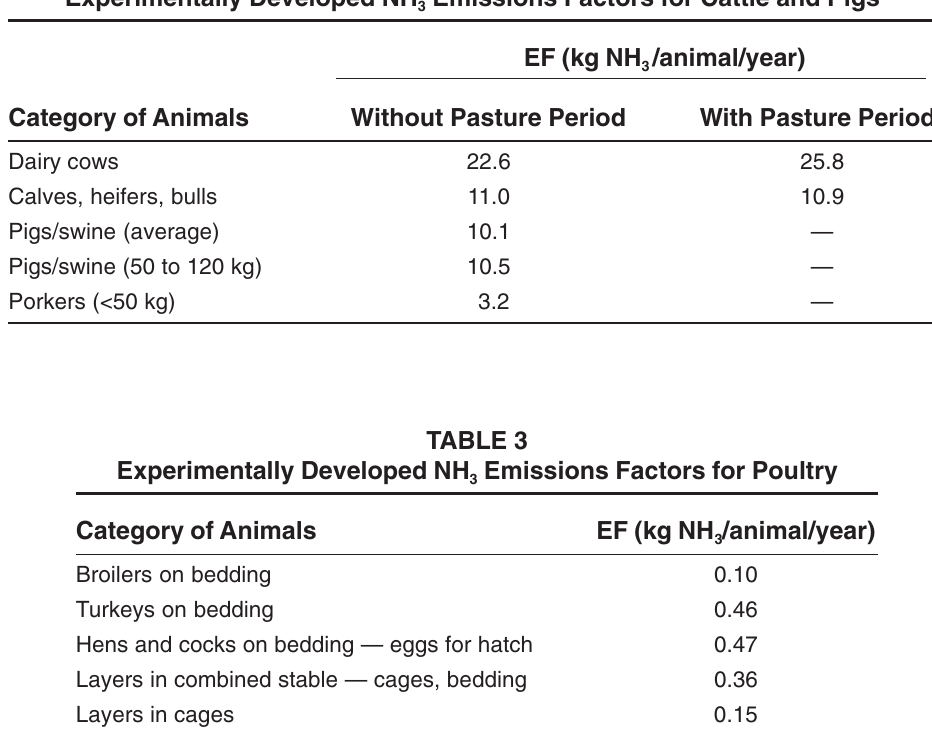
Experimentally Developed NH